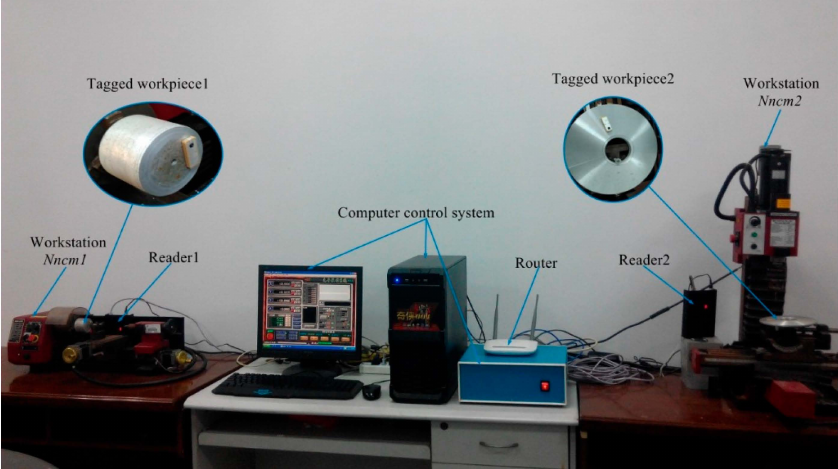
Figure 9. Physical experiment system of workpieces monitoring in real